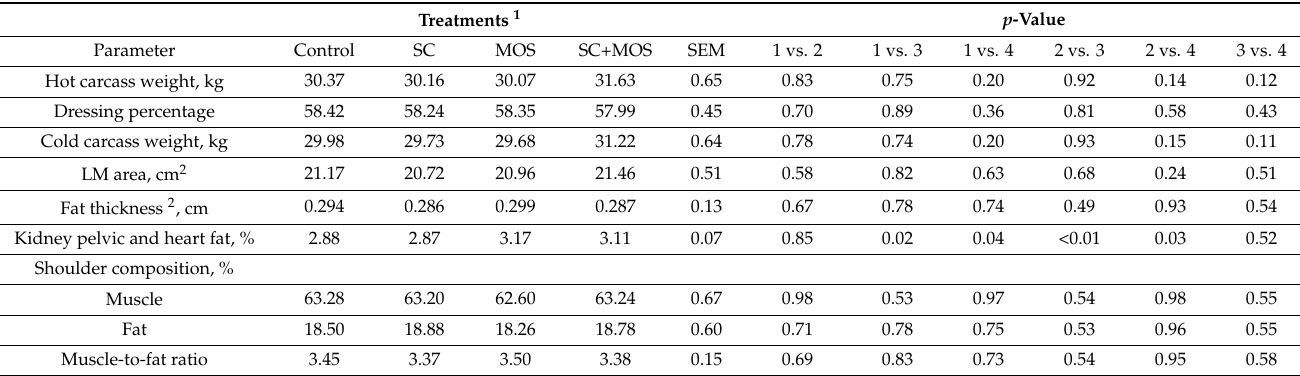
Muscle-to-fat ratio